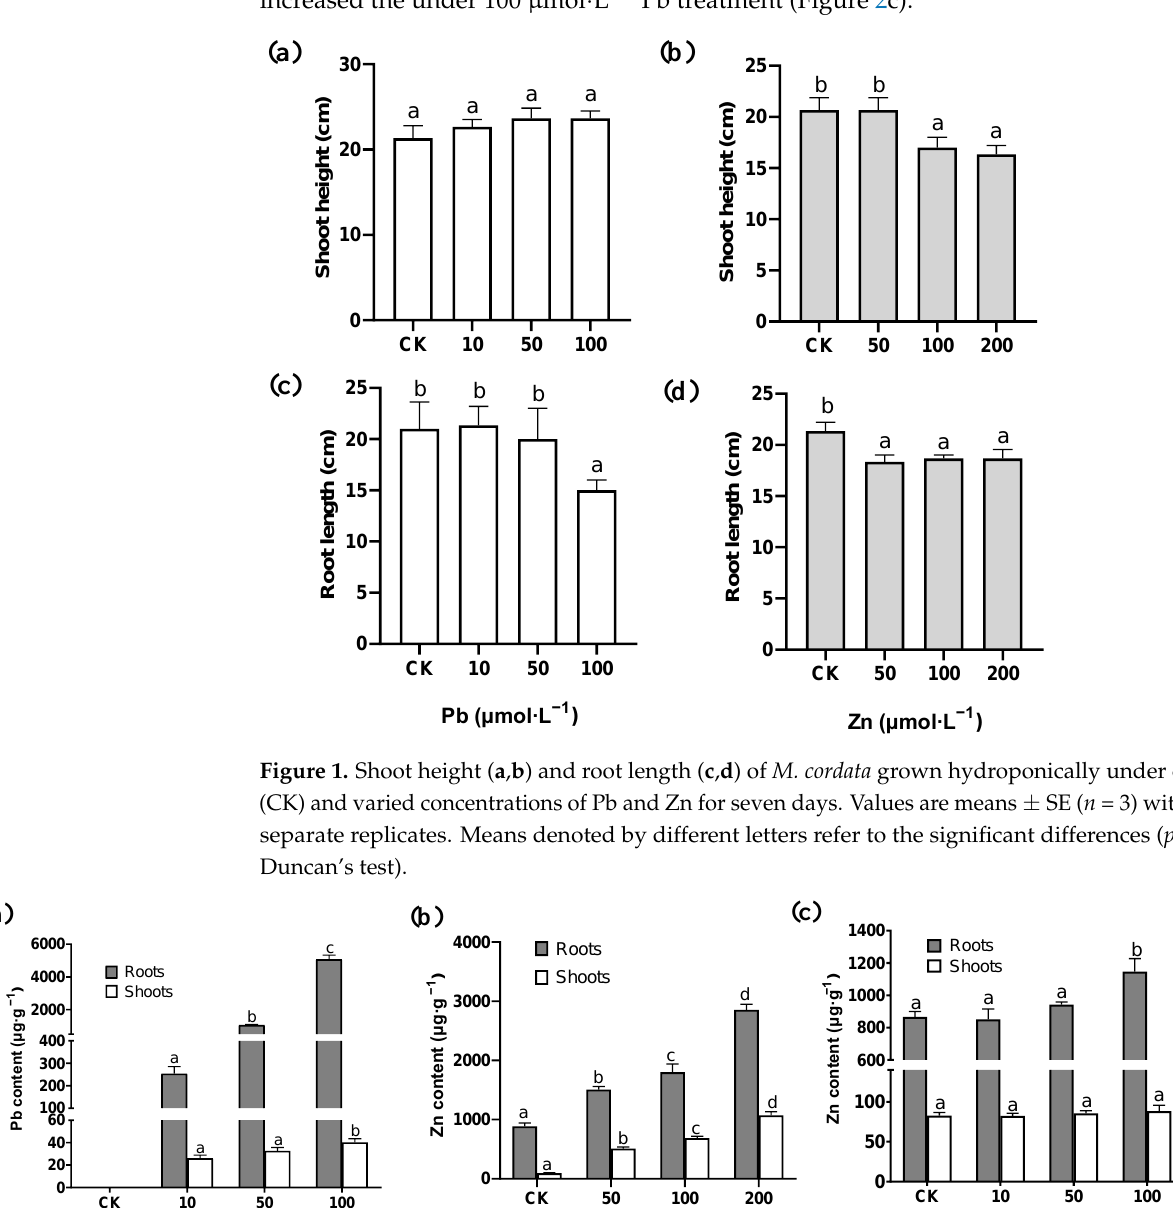
Figure 2. Pb ( a ) and Zn ( b , c ) content in shoots and roots of M. cordata grown hydroponically under control (CK) and varied concentrations of Pb and Zn for seven days. Values are means ± SE ( n = 3) with three separate replicates. Means denoted by different letters refer to the significant differences ( p < 0.05, Duncan’s